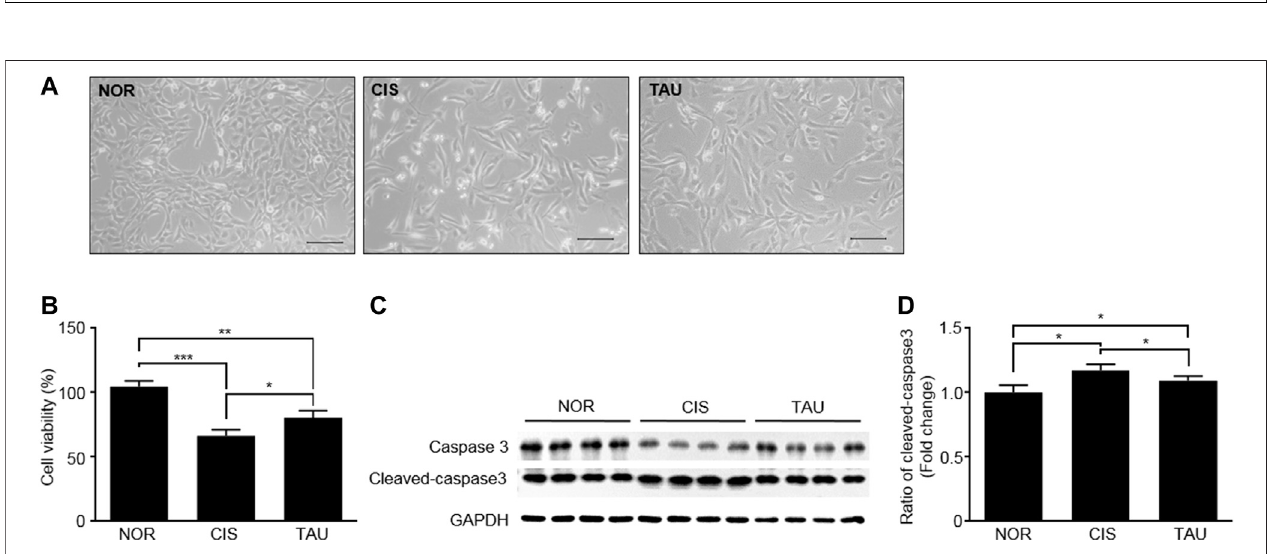
FIGURE2| TaurinesupplementationprotectedC2C12myoblastsagainstcisplatin-inducedcellviabilitydecrease. (A) Representativemorphologicalimagesofthe three groups of C2C12 myoblasts (NOR, CIS, and TAU). Scale bar, 100 μ m. (B) Percentage of cell viability measured by the MTS assay ( n (cid:2) 6). (C, D) Expression of caspase-3 and cleaved-caspase-3 in the three groups of C2C12 myoblasts ( n (cid:2) 8).